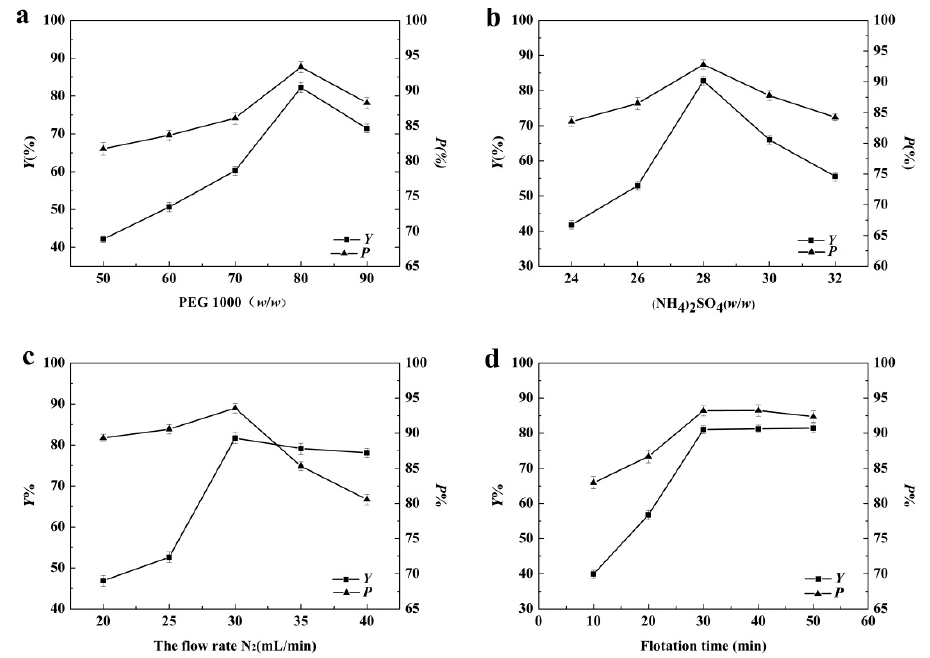
Figure 2. The effect of the concentration of PEG 1000 ( a ), the concentration of (NH 4 ) 2 SO 4 ( b ), the flow rate of nitrogen ( c ) and the flotation time ( d ) on the flotation .